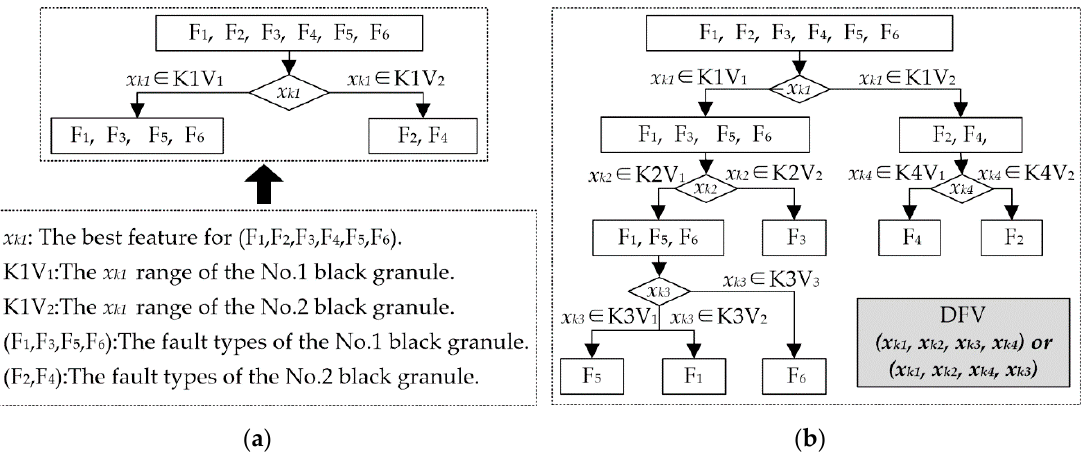
Figure 4. ( a ) Build the feature selection tree; ( b ) the heuristic tree and the composition and structure of DFV.